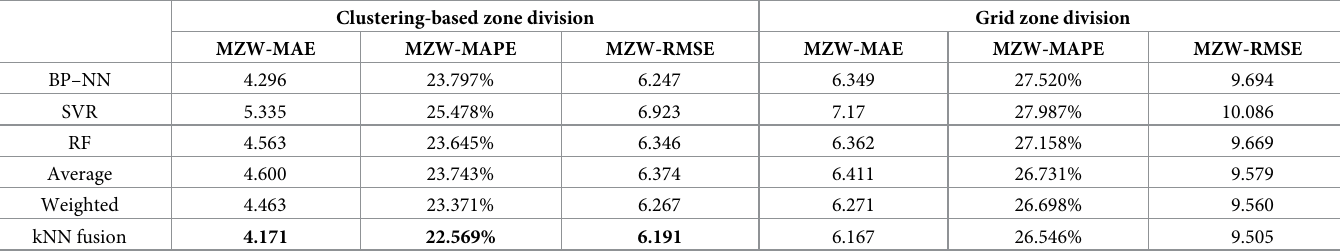
Table 2. Comparison of prediction performance between the clustering-based model and the grid-based model. Clustering-based zone division